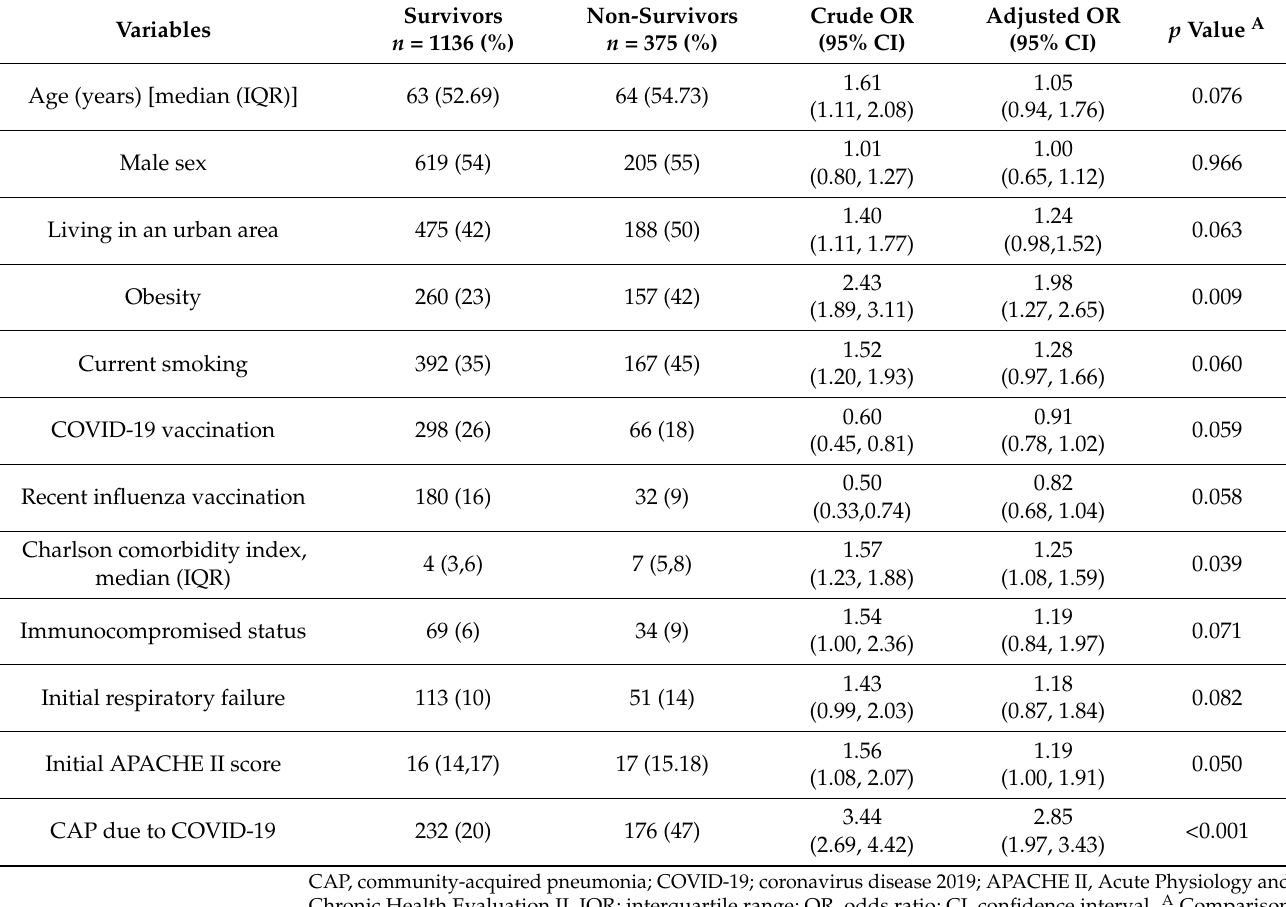
Table 6. Factors associated with in-hospital mortality among the patients with community-acquired pneumonia (CAP).